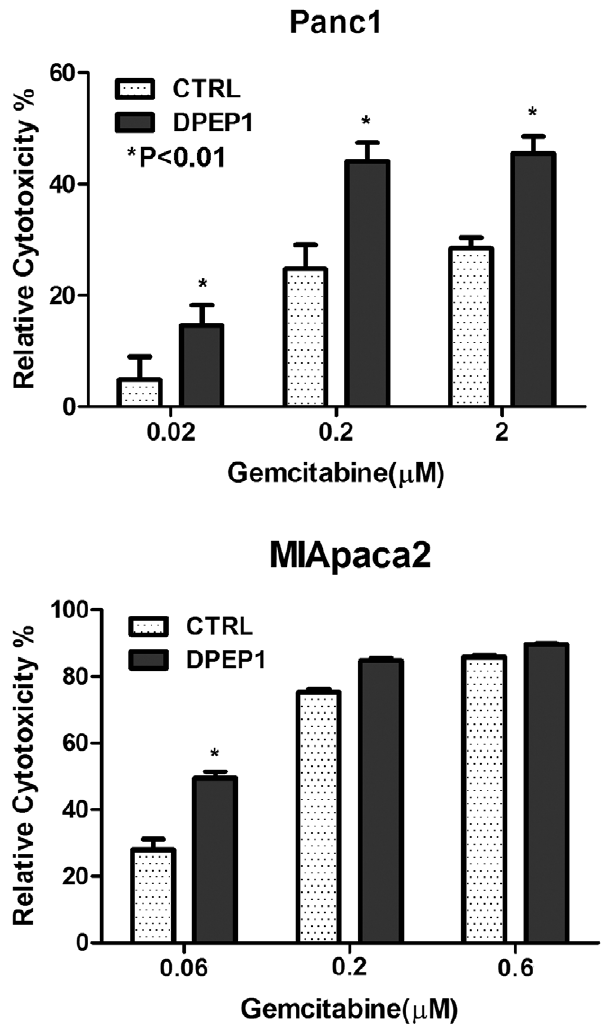
Figure 4. DPEP1 overexpression enhances sensitivity to gemcitabine. DPEP1 overexpressing cells and control cells were analyzed for cellular sensitivity to gemcitabine using Panc1 (A) and MIApaca2 (B). Overexpession of DPEP1 increased the sensitivity of Panc1 and MIApaca2 cells to gemcitabine. Control cells are Panc1 or MIApaca2 cells transfected with GFP control vectors. Cells were treated with Gemcitabine for 96 hours at different doses. The MTS assay was used to quantitate cytotoxicity (cell death) according to the manufac- turer’s instructions. Relative cytotoxicity (%) was calculated using the formula: [1 2 (OD 570 of drug treated cells/OD 570 of untreated cells)] 6 100%. Data are means 6 S.D. from 3 independent experiments. * T-test P ,